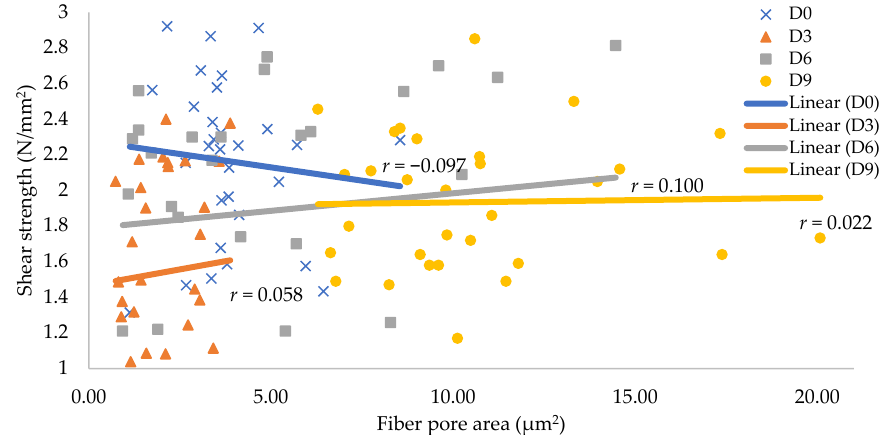
Figure 5. Coefficient correlation between the shear strength and fiber pore areas of the untreated and treated Paraserianthes falcataria glulam.